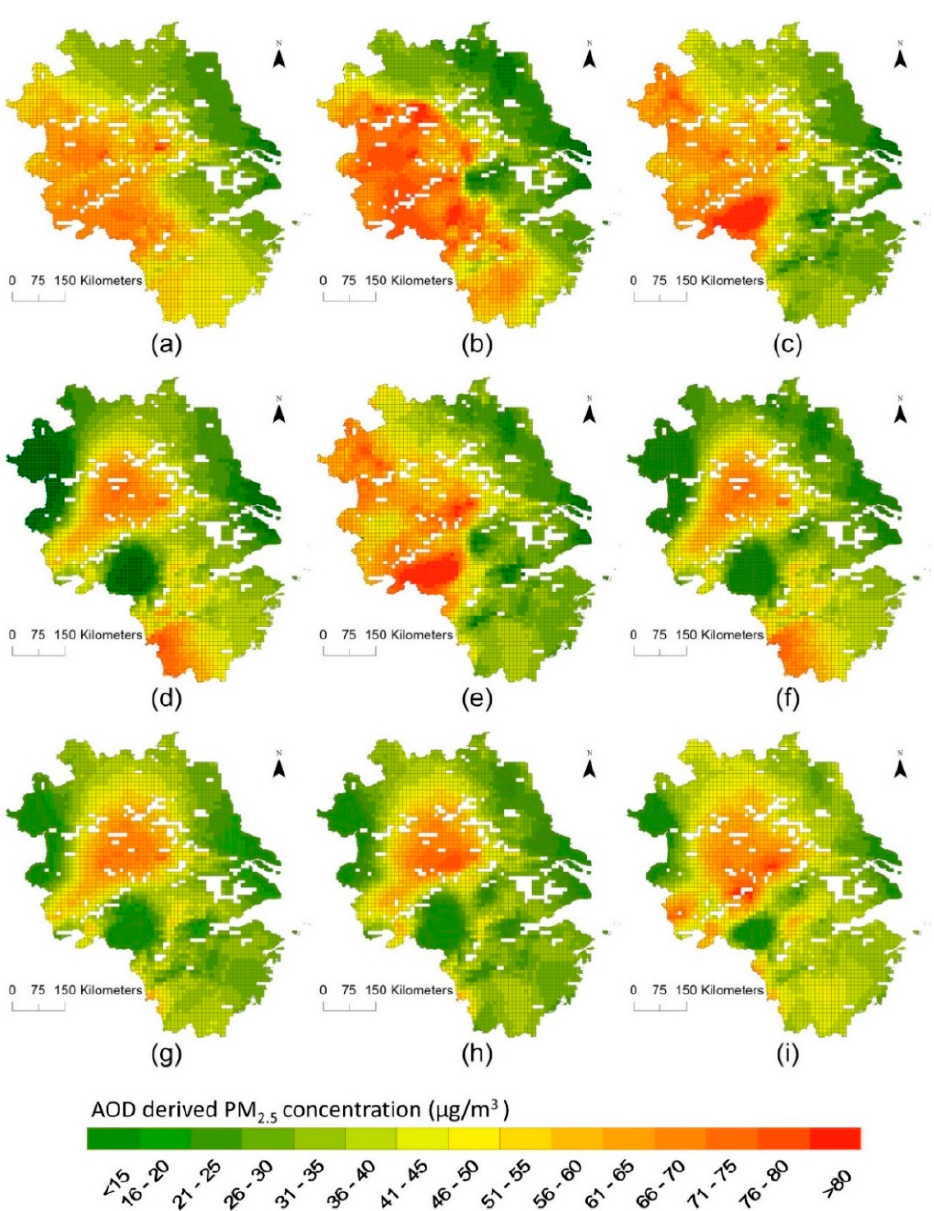
Figure 5. Spatial distribution maps of retrieved PM 2.5 concentrations of all 9 models on 16 September 2013. The radial basis interpolation (RBF) method was utilized to interpolate meteorological variables and grid them into cells with spatial resolution of 0.1 degree. ( a – i ) correspond to retrieved maps of PM 2.5 concentrations from models 1–9 in Table 3.